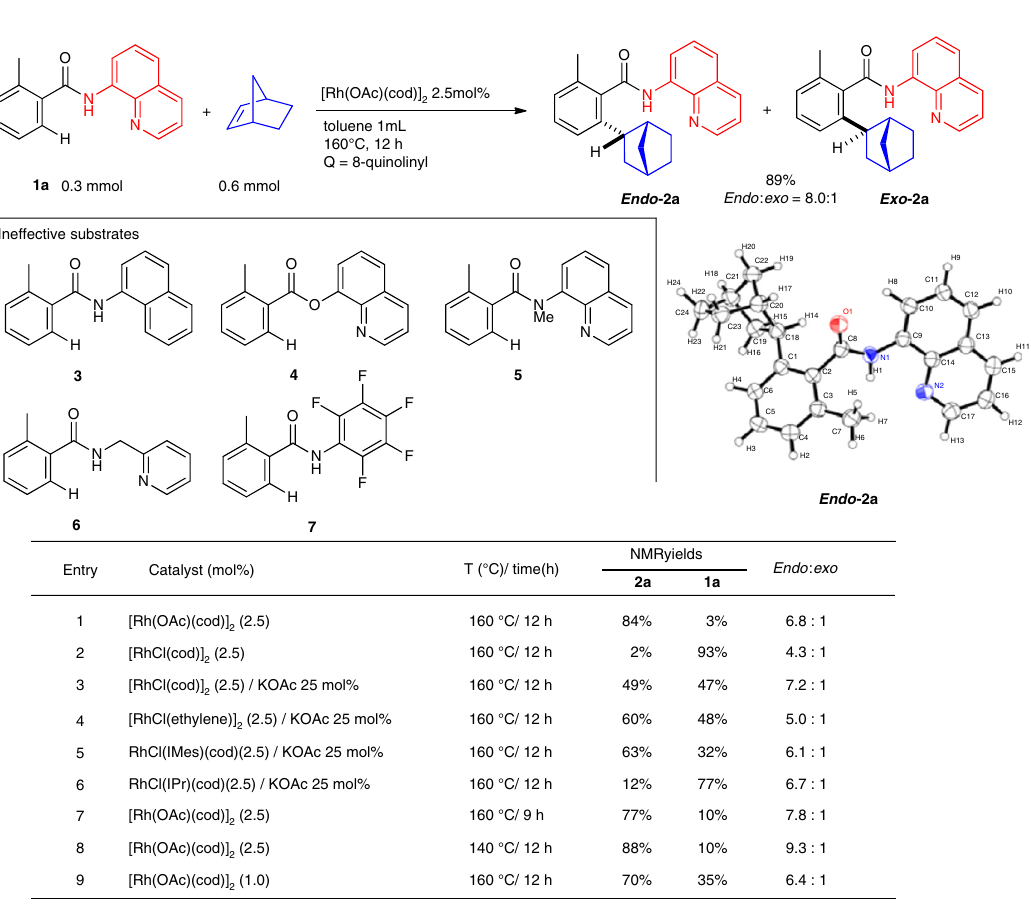
Fig. 2 Endo -selective hydroarylation of C – H bonds with norbornene. There are many examples of the exo -selective hydroarylation of C – H bonds with norbornene, but none of an endo -selective hydroarylation. An acetate ligand on the rhodium catalyst has a signi fi cant effect on the ef fi ciency of the